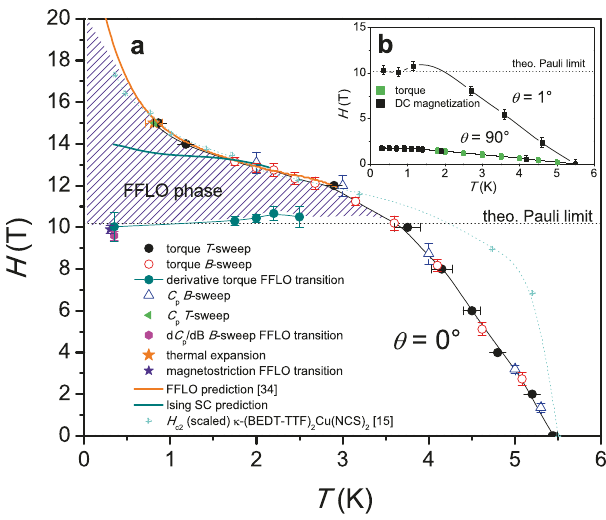
Fig. 5 Magnetic fi eld vs. temperature phase diagram of NbS 2 in magnetic fi eld applied parallel to the layer structure. a Filled black circles represent the upper critical fi eld H c2 ( T ) as measured by torque magnetometry during fi eld scans at constant temperatures ( B -sweep, Fig. 2a, b), red open circles represent the critical temperature T c ( H ) measured by torque during temperature scans ( T -sweep, Fig. 2c). Blue triangles are H c2 ( T ) data obtained from ac calorimetry measured during fi eld scans ( C p B -sweep, Fig. 3b). The orange star and green triangle mark the critical temperature in C T ) ( C T -sweep) and thermal expansion α ( T ) data measured in 15 T p ( p (Fig. 3a). The violet star marks a small additional transition anomaly (FFLO transition) in the magnetostriction and fi lled magenta circle marks a similar anomaly visible in the fi eld derivative of the speci fi c heat near the Pauli limit due to the transition separating the ordinary low- fi eld superconducting phase from the high- fi eld FFLO state (Fig. 4a). In addition, the dark cyan circles correspond to a small anomaly in the magnetic torque attributed to the same phase transition within the superconducting state (Fig. 4b). The orange and dark cyan lines are theoretical predictions of the low- temperature H c2 line for superconductivity with the Fulde – Ferrell – Larkin – Ovchinnikov (FFLO) state 34 and for Ising superconductivity, respectively. The FFLO phase is marked by the violet- shaded background. We have also added a scaled H c2 curve of the organic superconductor κ -(BEDT-TTF) 2 Cu(NCS) 2 , which shows a very similar upturn of the H c2 line due to the formation of an FFLO state 15 . Note that the characteristic temperatures/ fi elds have been marked in the data shown in Figs. 1 – 4. b H c2 data obtained from torque magnetometry in fi eld scans measured with a small misalignment angle ( θ = 1°, Fig. 1), for which no FFLO state is found, and for a fi eld applied perpendicular to the layer structure ( θ =